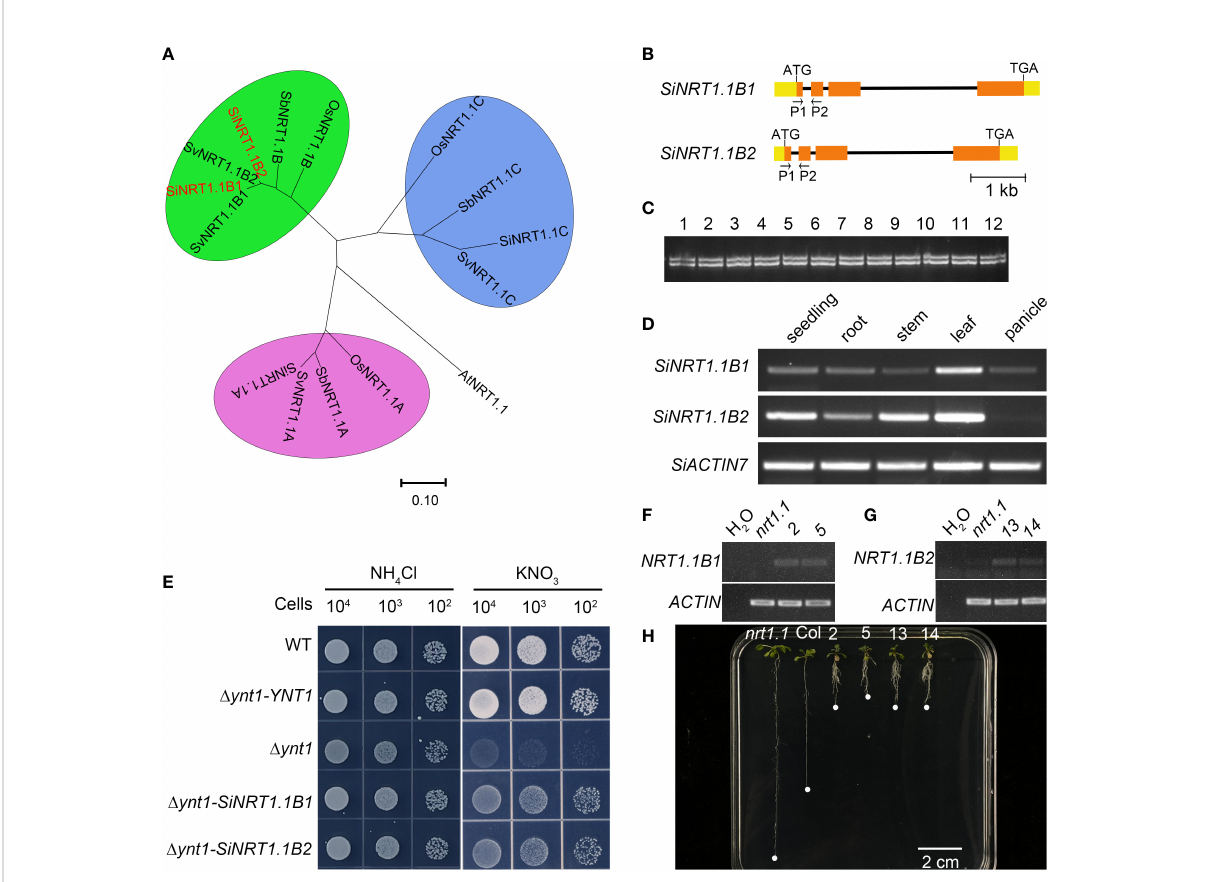
FIGURE 8 Duplication of the SiNRT1.1B gene might confers tolerance to low nitrate in foxtail millet. (A) The phylogenetic relationship of the NRT1.1 subfamily in Arabidopsis, rice, sorghum, foxtail millet and green foxtail. AtNRT1.1 (At1G12110), OsNRT1.1A (LOC_Os08g05910), OsNRT1.1B (LOC_Os10g40600), OsNRT1.C (LOC_Os03g01290), SiNRT1.1A (Si6g06290), SiNRT1.1B1 (Si9G32650), SiNRT1.1B2 (Si9G32660), SiNRT1.1C (Si9g56050), SbNRT1.1A (Sobic.007G044300), SbNRT1.1B (Sobic.001G302800), SbNRT1.1C (Sobic.001G541900). (B) Gene structure of the SiNRT1.1B1 and SiNRT1.1B1 genes. P1 and P2 are primers used for copy number analysis in Panel C (C) Copy number analysis of the SiNRT1.1B1 gene in Setaria . 1-8 are foxtail millet, and 9-12 are green foxtail. (D) The SiNRT1.1B1 and SiNRT1.1B2 expression pattern in various organs. (E) SiNRT1.1B1 and SiNRT1.1B2 rescued the yeast D ynt1 mutant. D ynt1 -YNT1, D ynt1-SiNRT1.1B1 and D ynt1-SiNRT1.1B2 are D ynt1 mutant strain transformed with the yeast YNT1 gene, SiNRT1.1B1 and SiNRT1.1B2 gene, respectively. (F) RT-PCR analysis of SiNRT1.B1 expression in atnrt1.1 mutant ( nrt1.1 ), wild type (Col) and two independent atnrt1.1 transgenic lines carrying a p SiNRT1.1B1::SiNRT1.1B1 gene (2 and 5). (G) RT-PCR analysis of SiNRT1.B1 expression in atnrt1.1 mutant ( nrt1.1 ), wild type (Col) and two independent atnrt1.1 transgenic lines carrying a p SiNRT1.1B2:: SiNRT1.1B2 gene (13 and 14). (H) SiNRT1.1B1 and SiNRT1.1B2 enhanced chlorate sensitivity of the atnrt1.1 mutant. nrt1.1 was atnrt1.1 mutant; Col was the wildtype, 2, 5, 13 and 14 were transgenic lines showed in Panels (F, G)